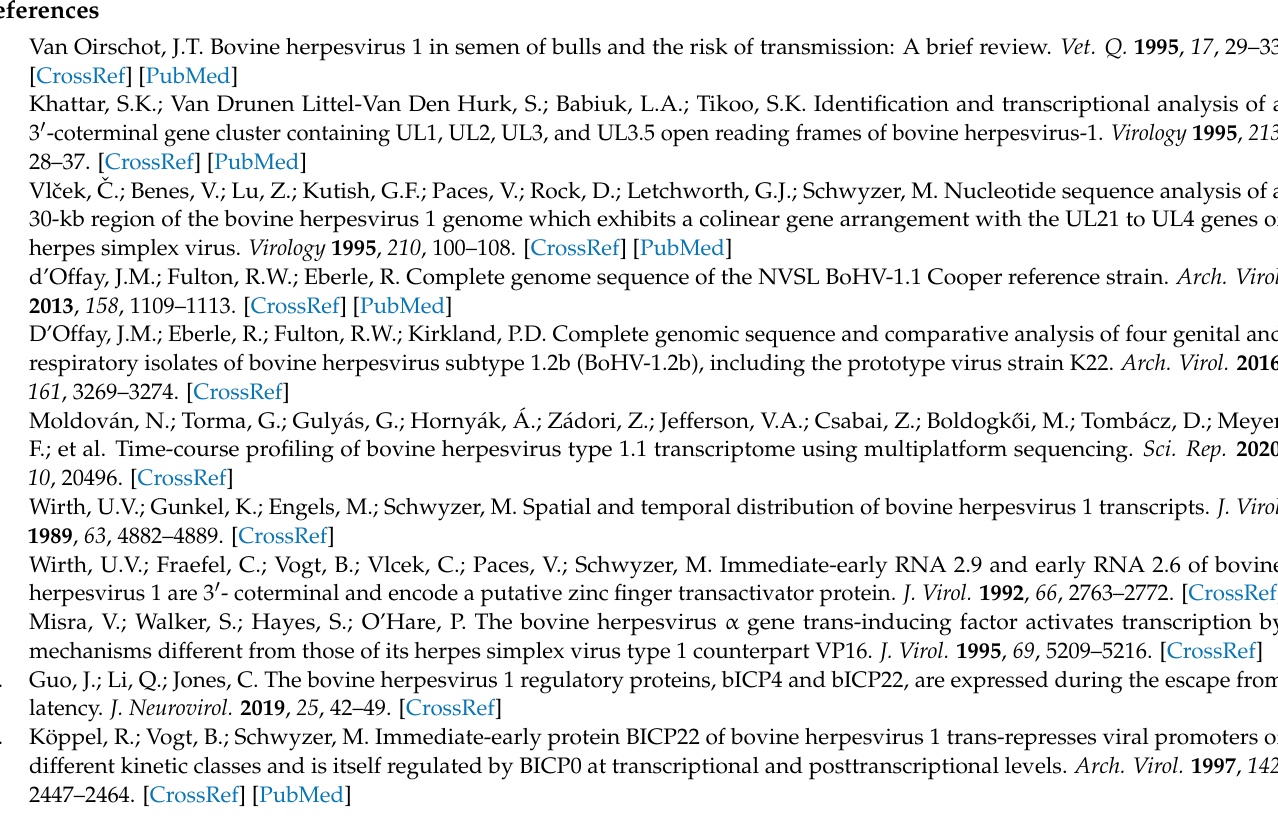
Figure S2: Long-read sequencing produces false TSSs; Figure S3: Whole-genome Kinetics of TSSs illustrated by bar plot; Figure S4: The proportion of the viral and host transcripts throughout the infection; Figure S5: Expression kinetics of BoHV-1 transcripts; Figure S6: Expression kinetics of BoHV-1 transcripts—delta values; Figure S7: Expression kinetics of BoHV-1 transcripts—fold values; Figure S8: TES clusters; Figure S9: Dynamics of TES expression along the entire viral genome; Figure S10: Whole-genome transcript dynamics; Figure S11: Isoform-switching in ul44, ul18, ul21 and ul40 genes; Table S1: List of transcription start and end sites of BoHV-1 transcripts; Table S2: BoHV-1 IE